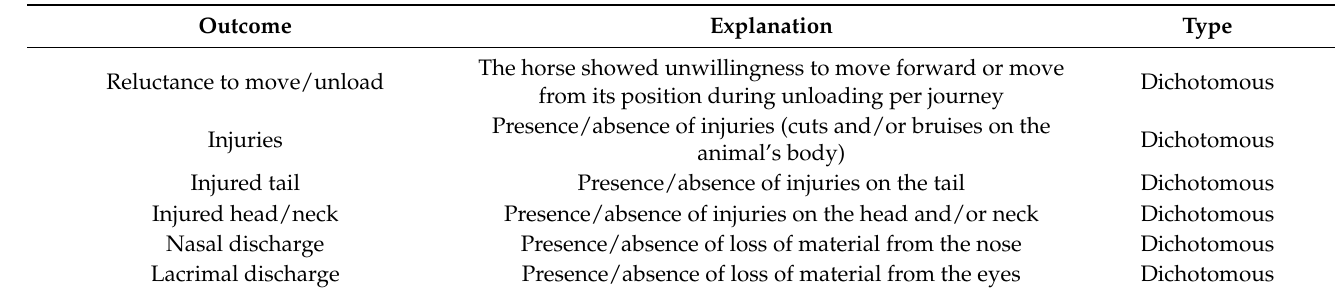
Table 3. Meaning and types of outcome variables concerning horse’s health and welfare-related parameters recorded at unloading or after arrival at the